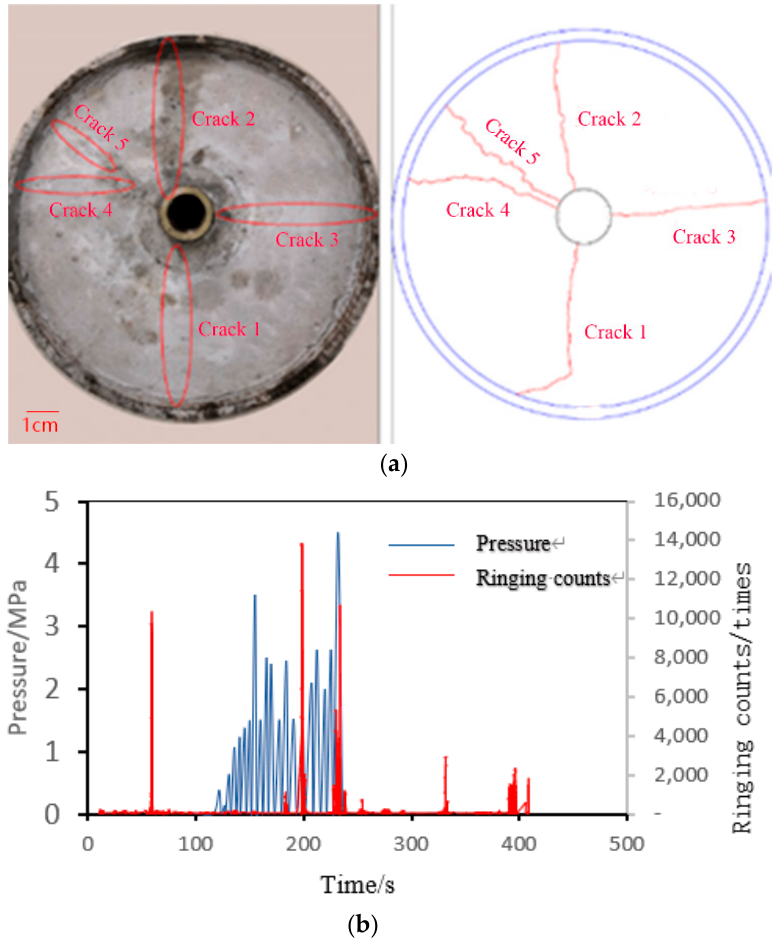
Figure 15. Rock-rock fracture under confined cyclic loading. ( a ) Crack propagation diagram; ( b ) AE signal during fracturing.